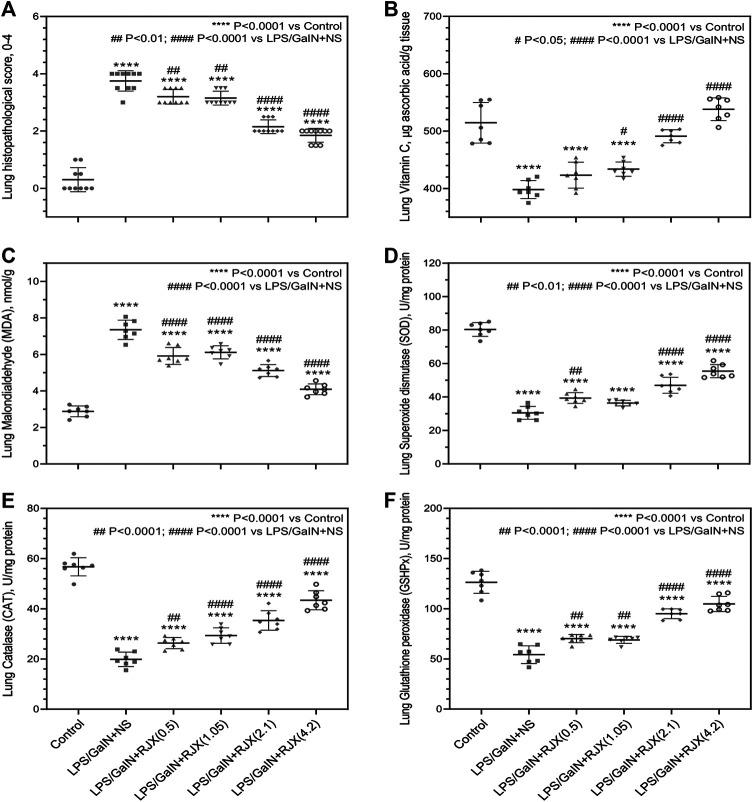
Tissue-Level In Vivo Anti-Inflammatory and Anti-Oxidant Activity of Rejuveinix (RJX) in the Lipopolysaccharide-Galactosamine (LPS-GalN) Mouse Model of acute respiratory distress syndrome (ARDS) and Multi-organ Failure. Mice were treated with i.p injections of RJX (0.5, 1.05, 2.1, 4.2 ml/kg, 0.5 ml/mouse) or normal saline (NS) 2 h before and 2 h post-injection of LPS-GalN. Except for untreated mice (Control), each mouse received 0.5 ml of LPS-GalN (consisting of 100 ng of LPS plus 8 mg of D-galactosamine) i.p. The RJX dose levels (in ml/kg) are indicated in parentheses. See text for discussion of results. These assays were performed on the lungs of mice that died after the LPS-GalN challenge. The lungs of the mice were harvested at the time of death which occurred within 24 h for all mice. The depicted lines represent the mean and standard deviation for the indicated parameters. In (A), the score was graded according to a 5-point scale from 0 to 4 as follows: 0, l, 2, three and four represented no damage, mild damage, moderate damage, severe damage and very severe damage, respectively. Statistical significance between groups is shown by: ****p < 0.0001 compared as control group and, ##p < 0.01; ####p < 0.0001 compared as LPS/GaIN + NS group, Kruskal-Wallis test and Mann Whitney test. In (B–F), ANOVA and Tukey’s post-hoc test were used for comparing the results among different treatment groups. Statistical significance between groups is shown by: ****p < 0.0001 compared as control group and, #p < 0.05; ##p < 0.01; ####p < 0.0001 compared as LPS/GaIN + NS group).